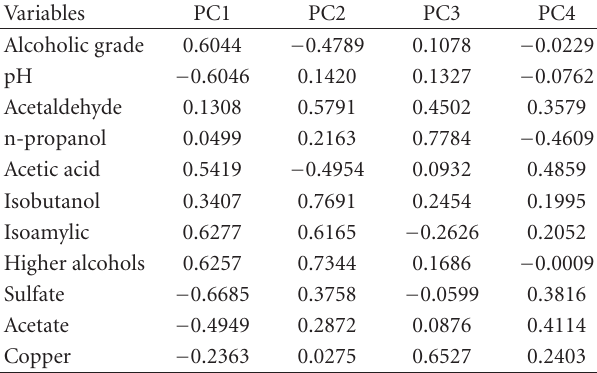
Table 4: Eigenvalues and cumulative variances of the first five principal